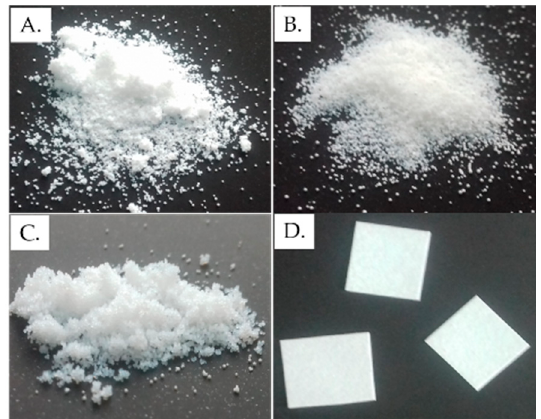
Figure 1. Pictures of carrier’s beads and membranes used in BPA transformation; ( A ) C2C carrier, ( B )